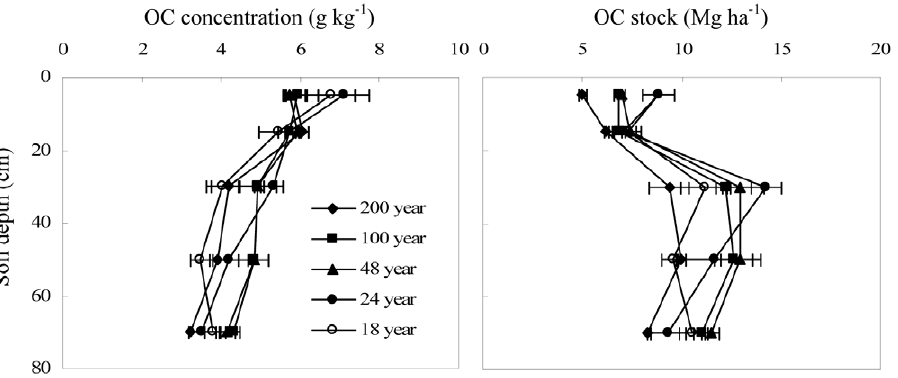
Figure 8. Vertical distribution of crop-derived OC (C 4 -C) concentrations and OC stocks in afforested farmland (the error bars are standard deviation of the means).